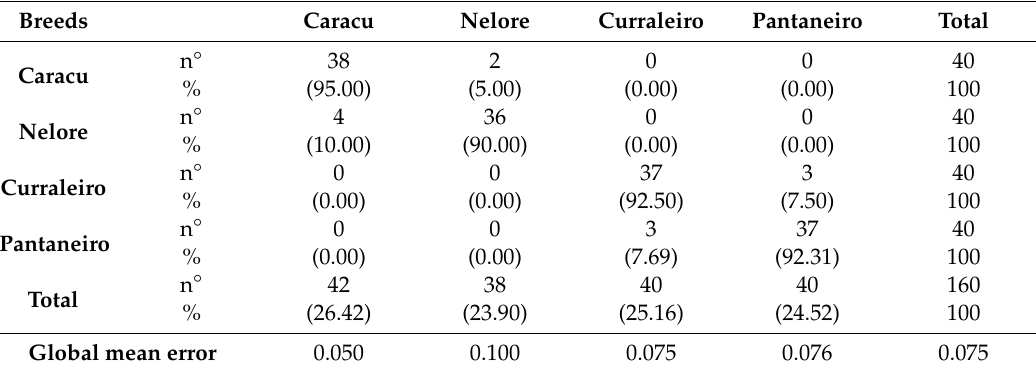
Table 4. Discriminant analysis and percentage of classification obtained from the microstructural characteristics of the guard hairs (trichological analysis) of cattle Bovino Pantaneiro, Curraleiro P é -Duro, Caracu and